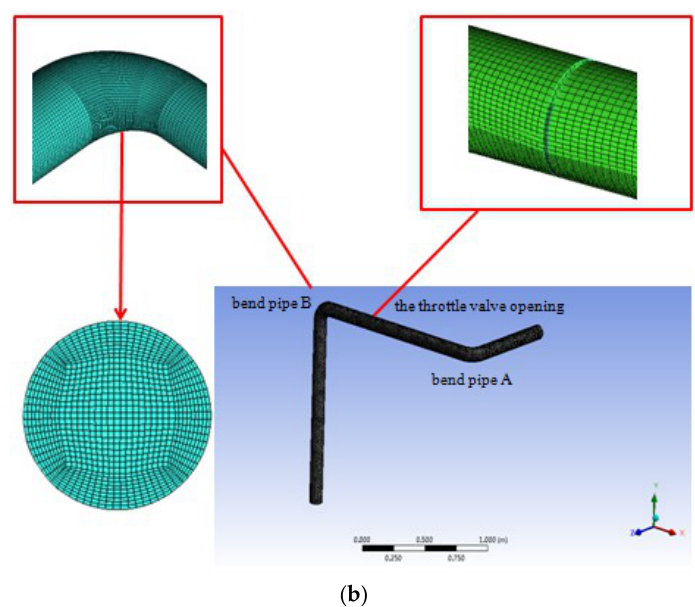
Figure 3. Erosion model of gas–solid two-phase flow pipeline. ( a ) Geometric model; ( b ) Finite element model.